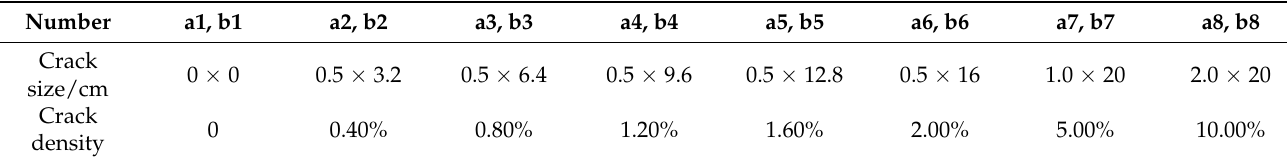
Figure 4. Soil water evaporation experiments for loess and sandy soil under different crack densities. ( a ) is a design diagram of different crack sizes on the sand soil, ( b ) is a design diagram of different crack sizes on the loess, a 1 and b 1 have no cracks, and a 2 to a 8 and b 2 to b 8 have different crack sizes. Table 2. Design parameters for different crack densities.